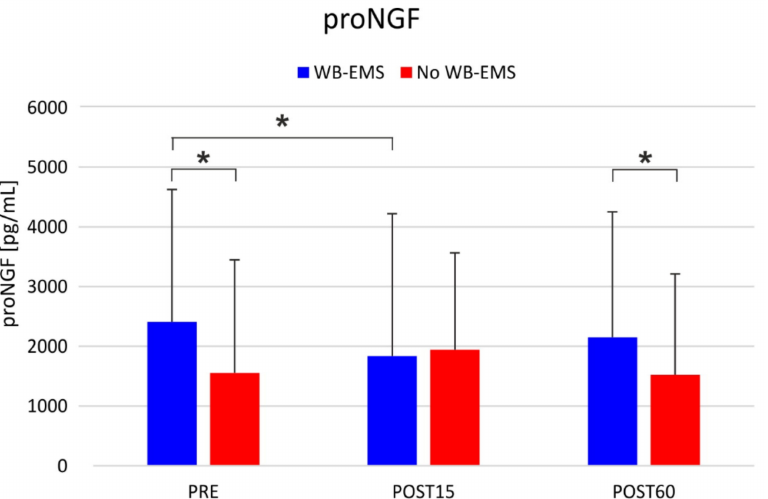
Figure 4. Level of proNGF variations: comparison between WB-EMS intervention and no WB-EMS intervention and pre- and post-assessment (15 and 60 min). * p < 0.05; pg/mL: picograms/millimeters.